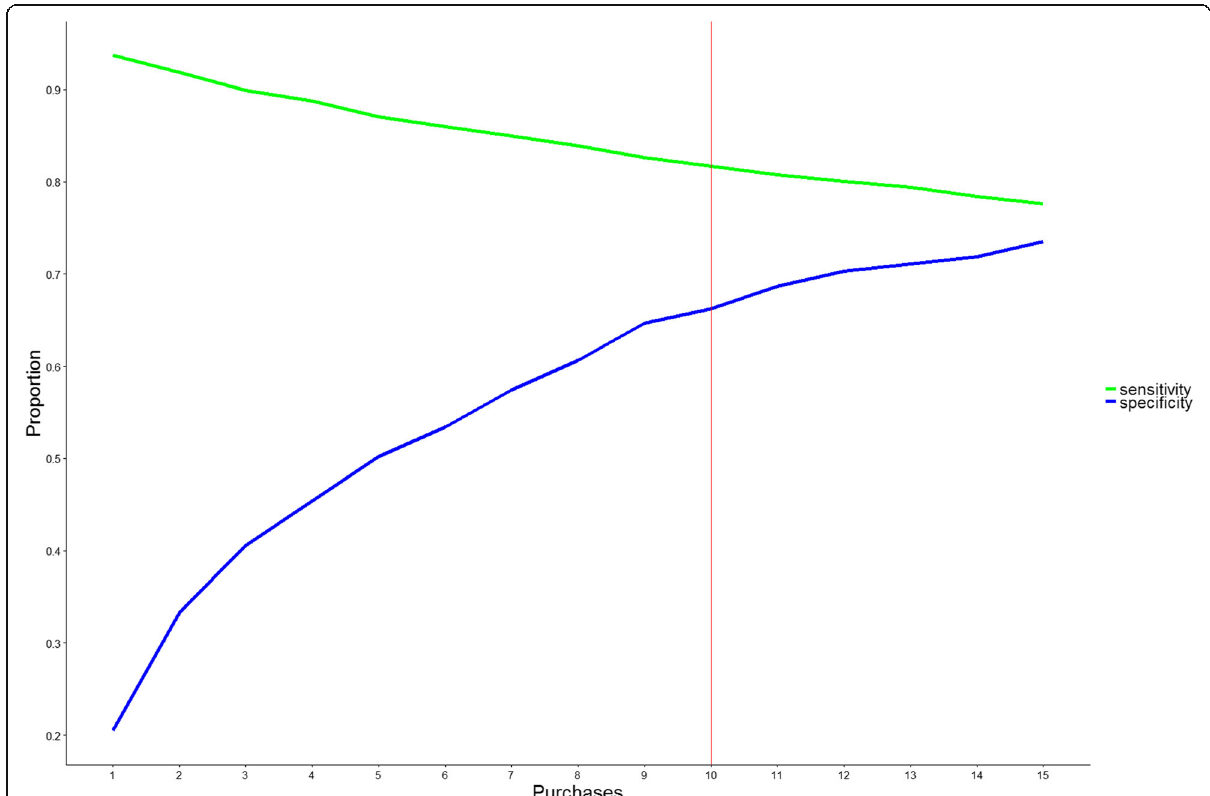
Fig. 2 The sensitivity and specificity for triptan purchases to predict a positive treatment response. The figure presents the sensitivity (green) and specificity (blue) at different thresholds of minimum number of triptan-purchases, e.g. patients with ten or more triptan purchases had a sensitivity of 82% and specificity of 66% for prediction of positive treatment response (red